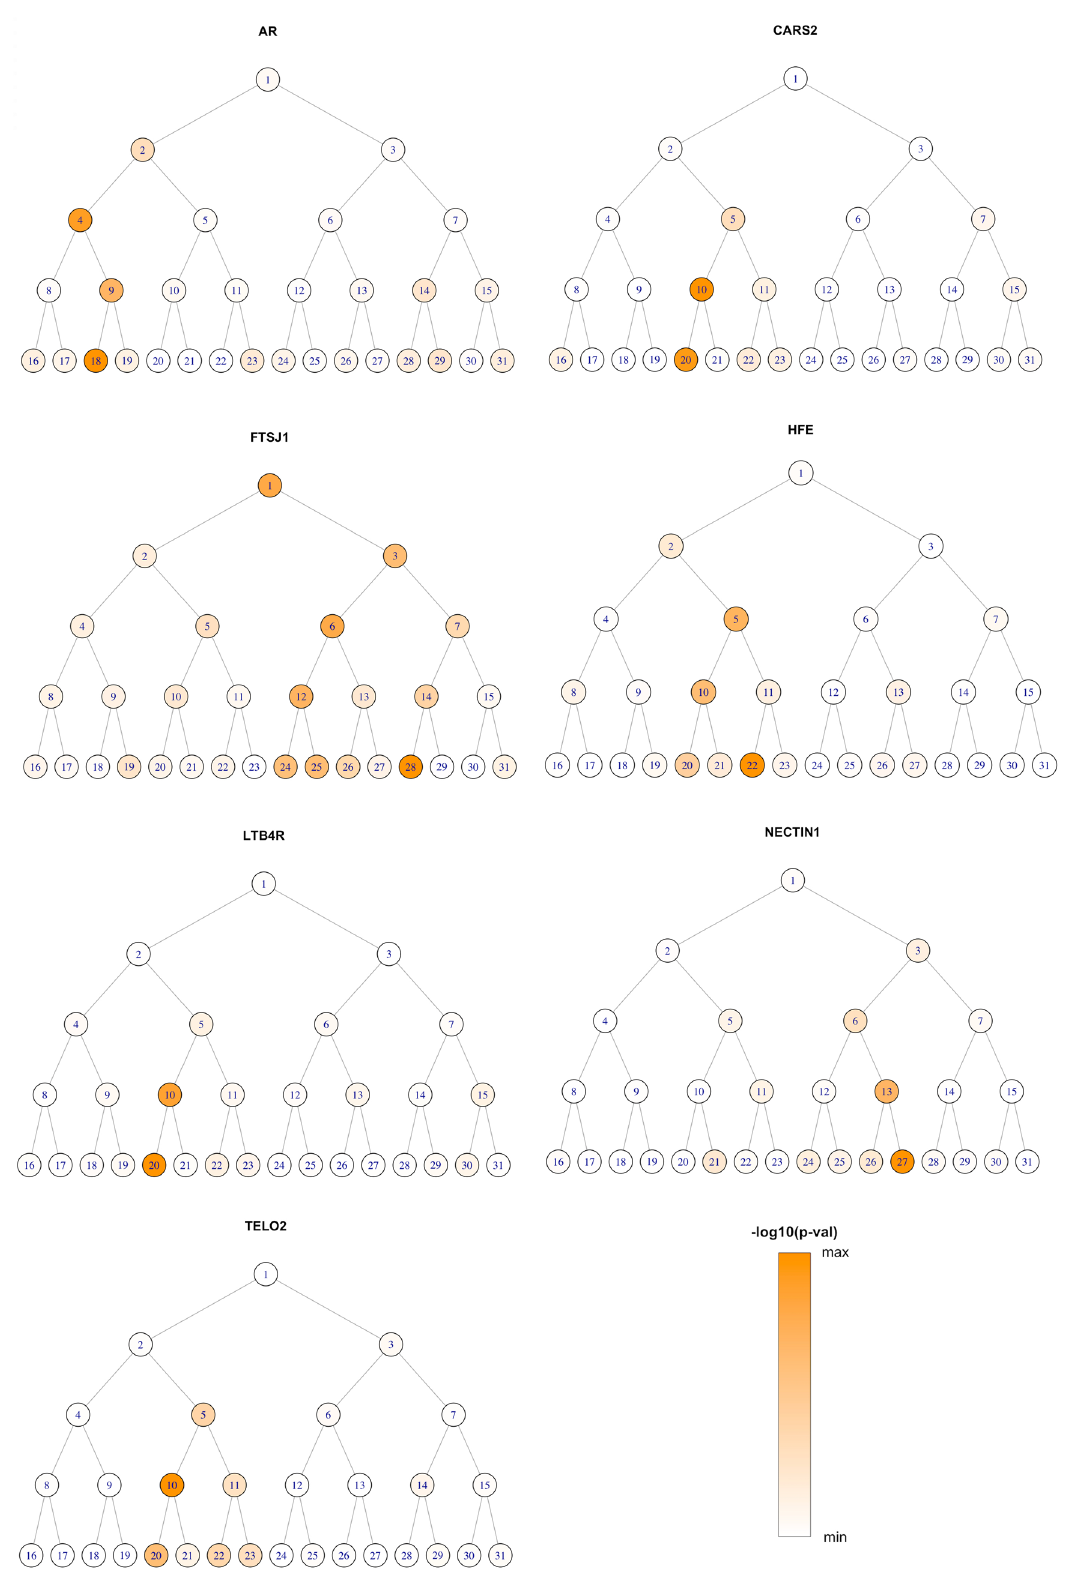
Figure 3. Module-wide association results for significant genes. For each gene, the –log10 p - value is shown as color shades ranging from min to max, for 31 facial segments arranged the same way as Fig. 1. The global-to- local phenotyping enabled the discovery of genetic effects at different